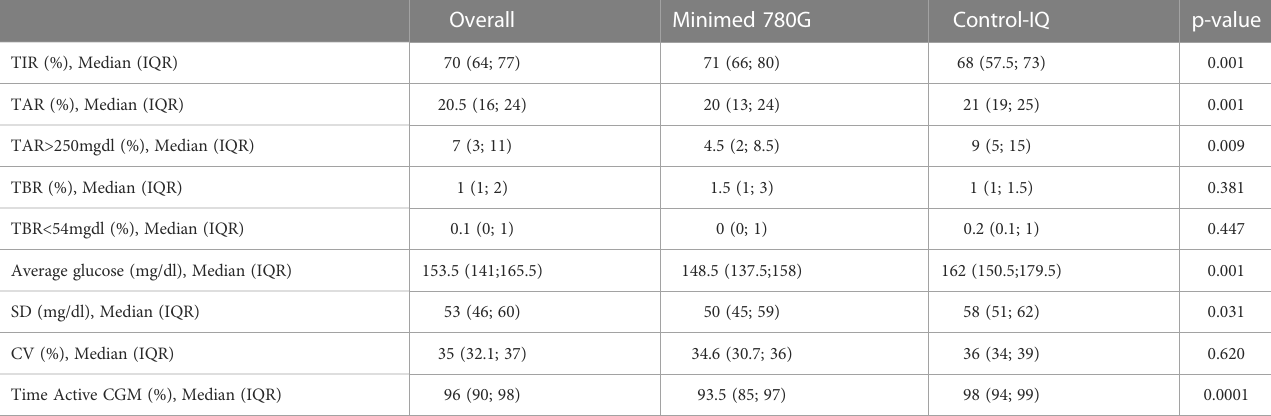
TABLE 2 Treatment effects overall and by group at T2.